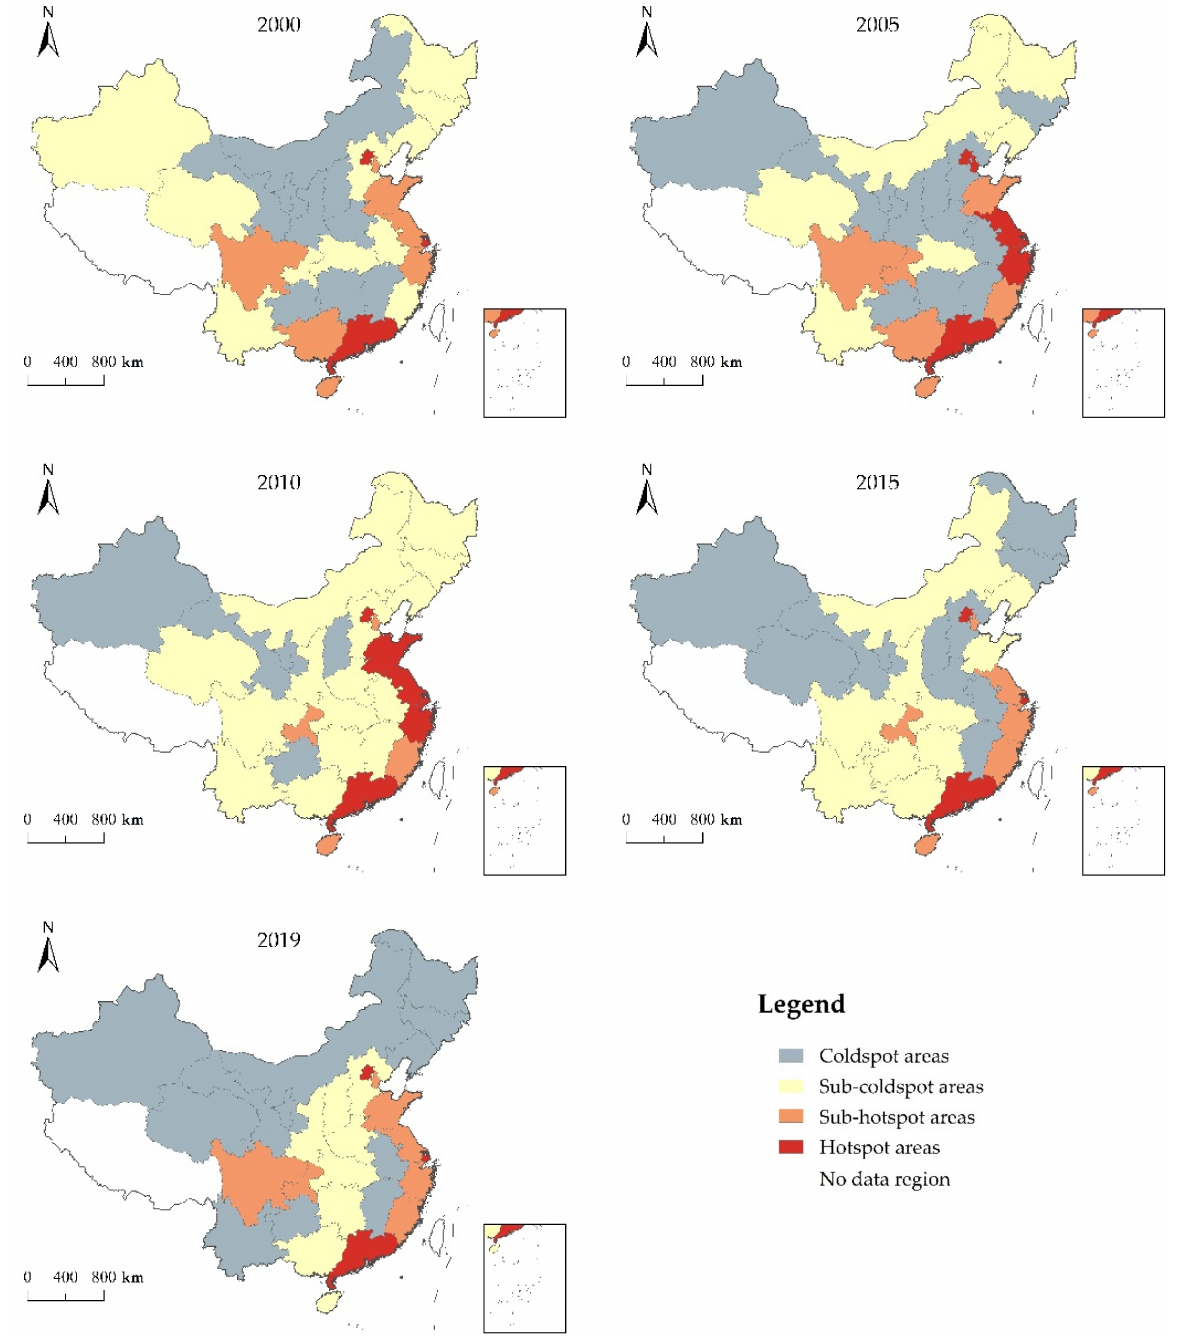
Figure 2. Spatial evolution of a cold spots and hotspots of coordinated development in